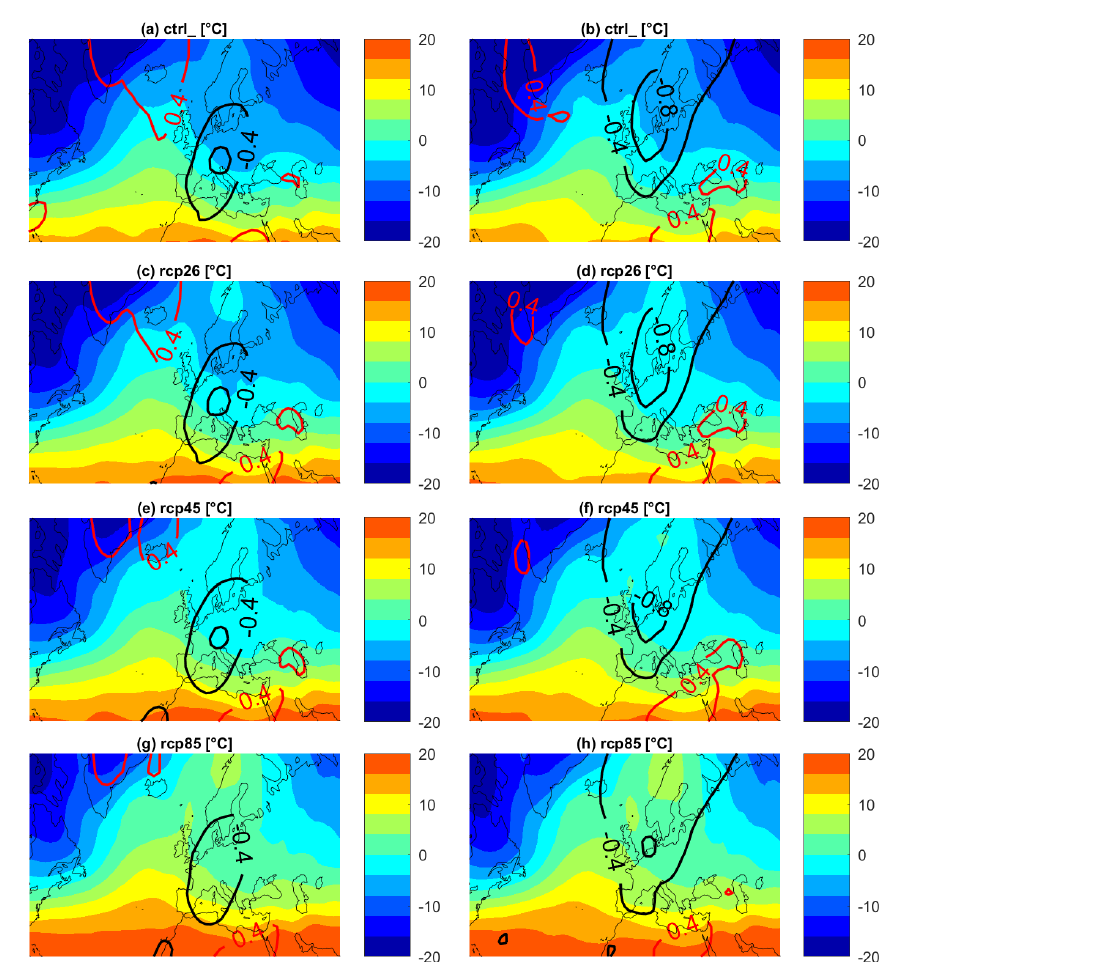
Figure 8. The figure shows 850hPa temperature in PlaSim simulations: average of the 850hPa temperature [ ◦ C] for cluster 1 (a, c, e, g) and cluster 2 (b, d, f, h) of analogues. (a, b) Control run. (c ,d) RCP2.6 run. (e, f) RCP4.5 run. (g, h) RCP8.5 run. Isolines represent positive (in red) and negative (in black) standardized